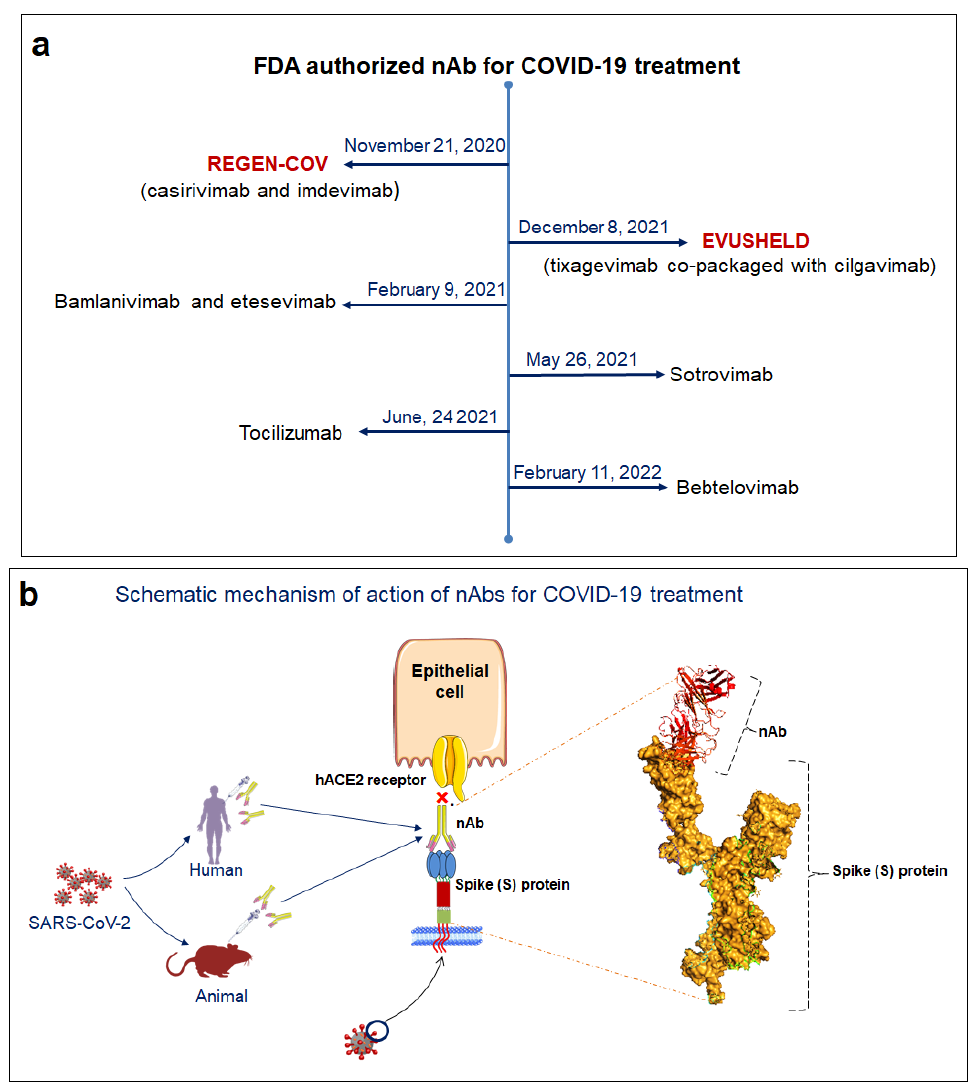
Figure 9. FDA approved mAbs against SARS ‐ CoV ‐ 2 and their mode of action. ( a ) Timeline